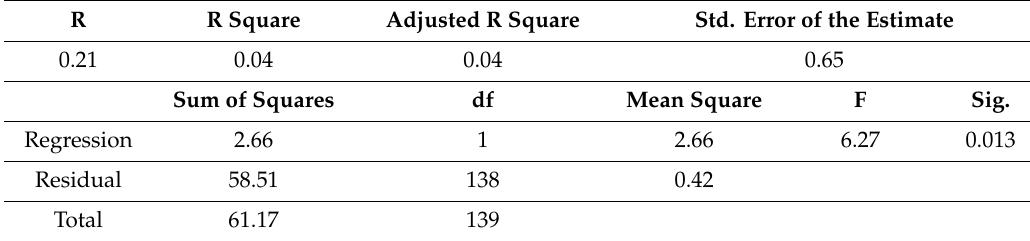
Table 8. Model Summary (Community Planning Potential), ANOVA (Community Planning Potential). R R